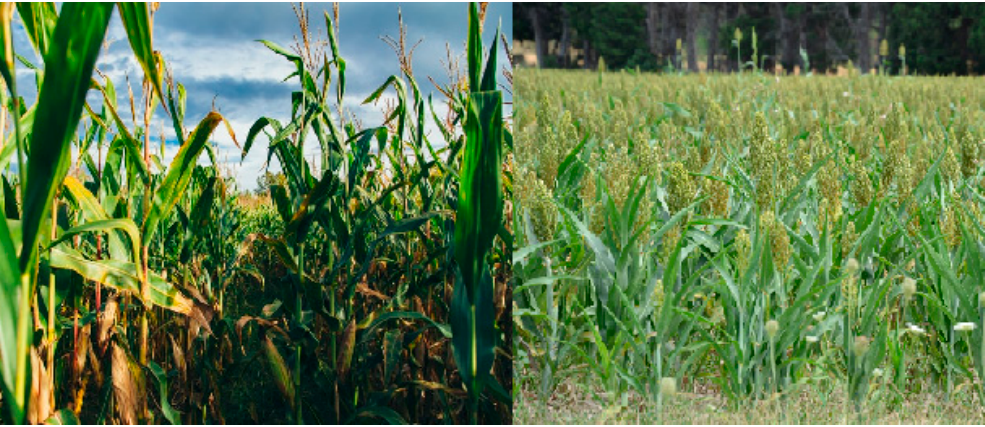
Figure 2. Plants of maize and sorghum.